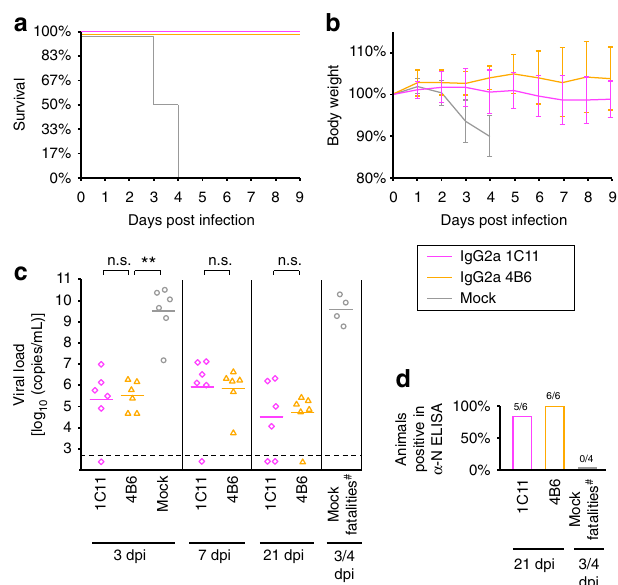
Fig. 6 1C11 and 4B6 protect IFNAR -/- mice from lethal SBV infection. a , b Survival curves ( a ) and relative body weight development ( b ) of antibody-treated and untreated mice over the fi rst nine days post infection ( n = 6 per group). The mAbs had been administered 24 h prior to challenge infection. Weights are given as mean percentage ± s.d. c Viral genome loads at 3, 7, and 21 dpi or on the day when an unvaccinated animal had to be euthanized (fatalities). Horizontal bars represent mean values. The dashed line indicates the detection limit. Statistical analysis was performed using the Mann – Whitney rank sum test. ** P < 0.01; n.s. not signi fi cant ( P > 0.05). d Percentage of animals with N protein-speci fi c antibodies at 21 dpi or on the day when an unvaccinated animal had to be euthanized. The numbers of seroconverted animals in each category is indicated. # Two of six mock-treated animals naturally succumbed to the infection and were thus not available for blood analysis. Source data are provided as a